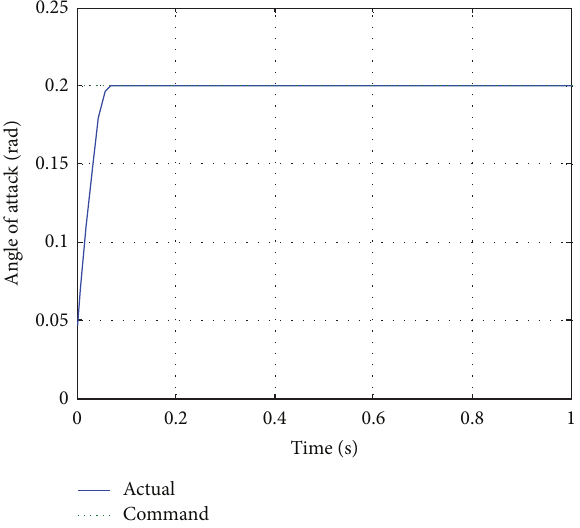
Figure 7: The response of angle of attack.